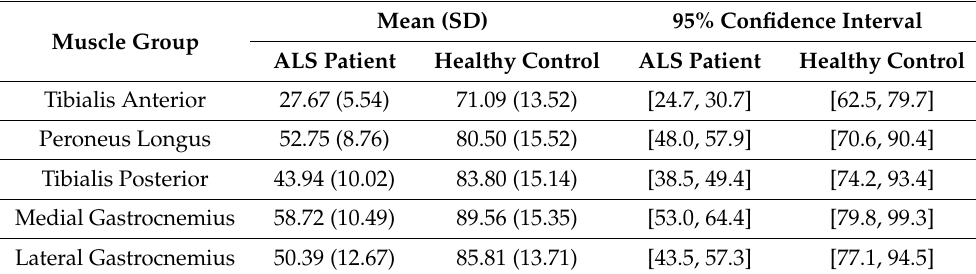
Figure 2. An example axial slice of T1w calf image is shown in ( A ) for an ALS patient and a healthy control. The control slice is highlighted with an anterior (blue) compartment comprising of the tibialis anterior (TA) and peroneus longus (PL) muscle ROIs and posterior (green) compartment comprising of the tibialis posterior (TP), medial and lateral gastrocnemius (MG and LG, respectively) muscle ROIs. TRATE, Fat Fraction and T2 maps were compared between the ALS and healthy control populations as shown in ( B – D ), respectively. TRATE was observed to be lower in ALS-affected muscle. While in some datasets obtained, fatty infiltration in ALS-affected muscle was observed, the dataset shown above is an example observation of similar fat content in healthy and ALS-affected muscle. In accordance with existing muscle imaging studies, the T2 map showed sporadic elevated regions in ALS muscle, but these changes were minor when compared with changes in TRATE measures. Table 2. Range of TRATE [mM − 1 s − 1 ] values in ALS and Healthy Control